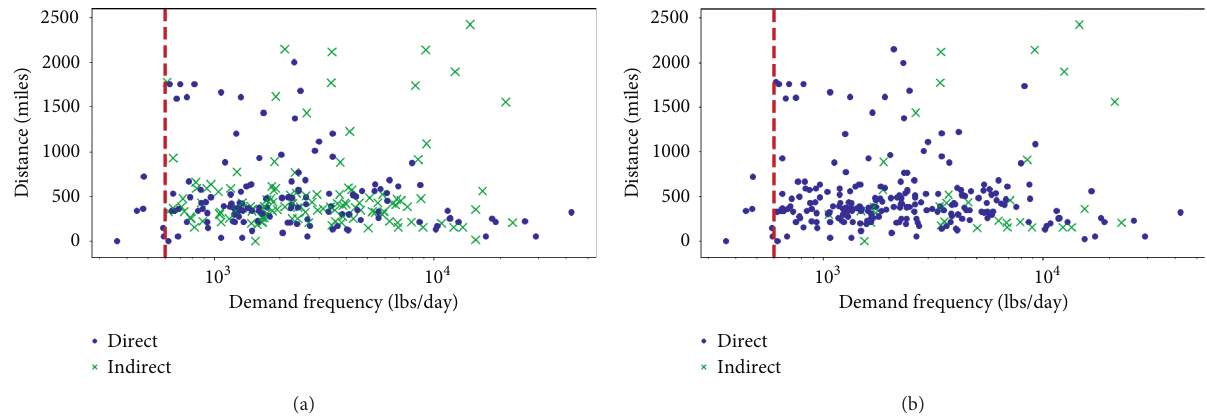
Figure 4: Distance versus demand frequency. Green x’s denote customers that were serviced by the indirect strategy at least once, and blue dots denote customers that were only serviced by the direct strategy. Red dotted lines represent a demand frequency of 600 lbs/day; customers with a lower demand frequency only received goods by the direct strategy, per company policy. (a) All historical company data. (b) The last two months of data.